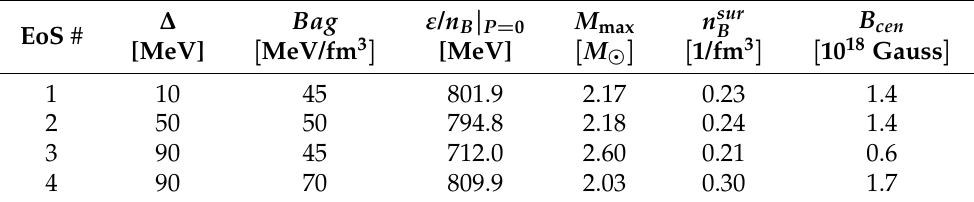
Table 2. Parameters for the four chosen EoSs. All the sets satisfy the strange matter stability hypothesis and the mass constraint M max ≥ 2.01 M (cid:12) . We also show the surface baryonic density, n sur and the central MF strength, B cen , for each